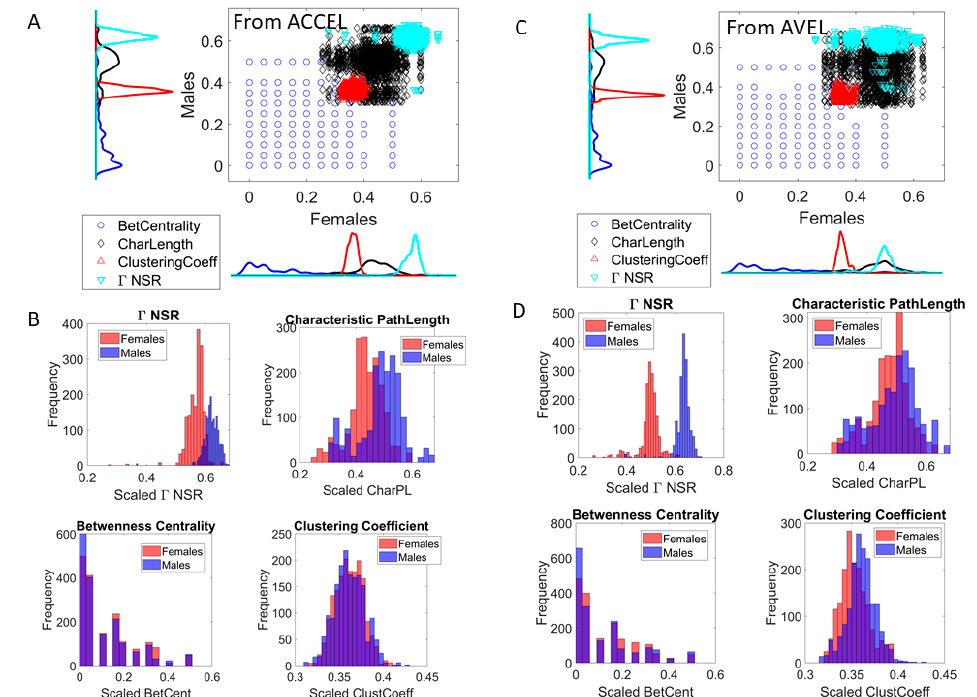
Figure 9. Digital ADOS automatically separates females from males in a random draw of the population. ( A ) Scatters and histograms of parameters derived from interconnected networks representing the dynamic dyad provide evidence for fundamental di ff erences in connectivity across the nodes of the network composed by the child and clinician dyad. ( B ) The empirically estimated Gamma scale parameter (the noise to signal ratio, (NSR)) of the micro-movement spikes (MMS) derived from acceleration separate females from males with lower NSR in females and tighter distribution than males. The characteristic pathlength denoting average shortest distance path from each node to every other node of the network is significantly shorter in females than in males. The betweenness centrality is higher in females than males and the clustering coe ffi cient is also higher in females. All di ff erences are statistically significant with p << 0.01. ( C ) Summary graph for angular speed is consistent with the acceleration patterns. ( D ) Females show lower NSR, lower characteristic pathlength and higher betweenness centrality and lower clustering coe ffi cient. All di ff erences are statistically significant according to non-parametric rank-sum test p <<